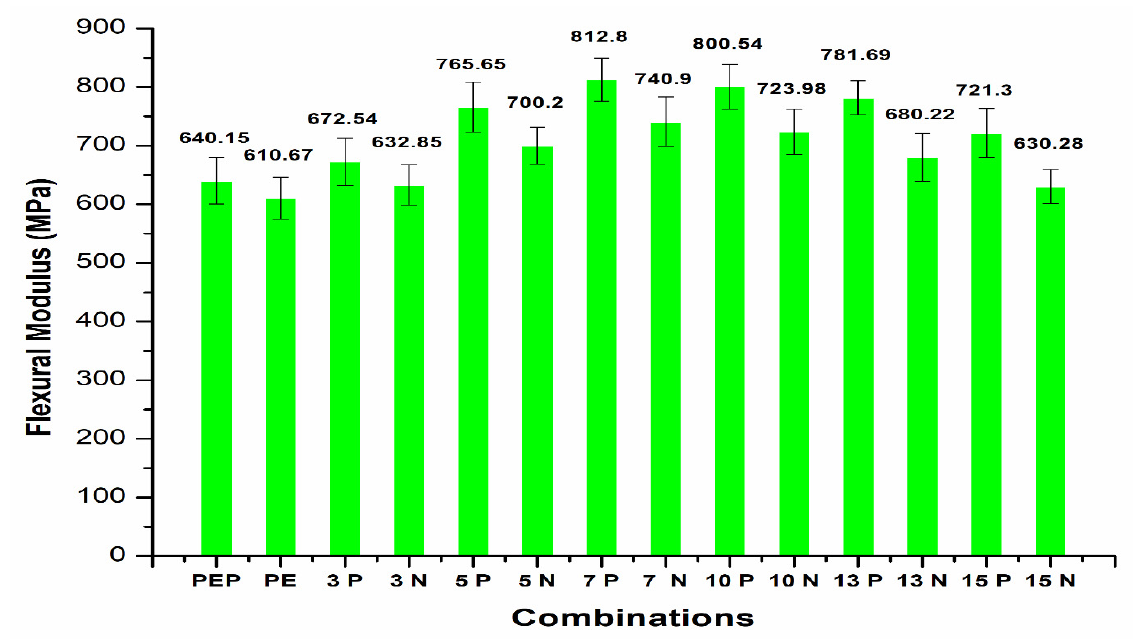
Figure 16. Flexural modulus of CF/PE composites.